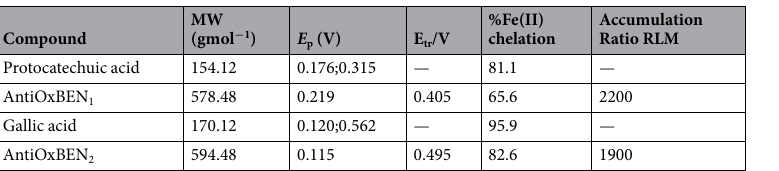
different oxidative stressors, FeSO 4 /H 2 O 2 /ascorbate and ADP/FeSO 4 , and two end-points, TBARS production and oxygen-consumption, were used. MitoQ 10 was used as reference (Fig. 3). When measuring TBARS, gallic acid and AntiOxBEN 2 were the most effective hydroxybenzoic acid deriv- atives in preventing mitochondrial lipid peroxidation, while AntiOxBEN 1 and protocatechuic acid were not effective in preventing TBARS formation in RLM (Fig. 3c). Time-dependent oxygen consumption (Figure S2) resulting from the lipid peroxidation of RLM membranes was also monitored 22, 23 . The time lag-phase that fol- lowed ADP/Fe 2 + addition was used to measure the AntiOxCINs efficiency (Fig. 3d). In the ADP/FeSO 4 assay, none of AntiOxBENs efficiently prevented lipid peroxidation. The ability of AntiOxBENs vs MitoQ to inhibit lipid peroxidation in RLM decreased in the order MitoQ ≫ AntiOxBEN 2 ≈ gallic acid > AntiOxBEN 1 ≈ protocatechuic acid. In general, pyrogallol-based AntiOxBEN